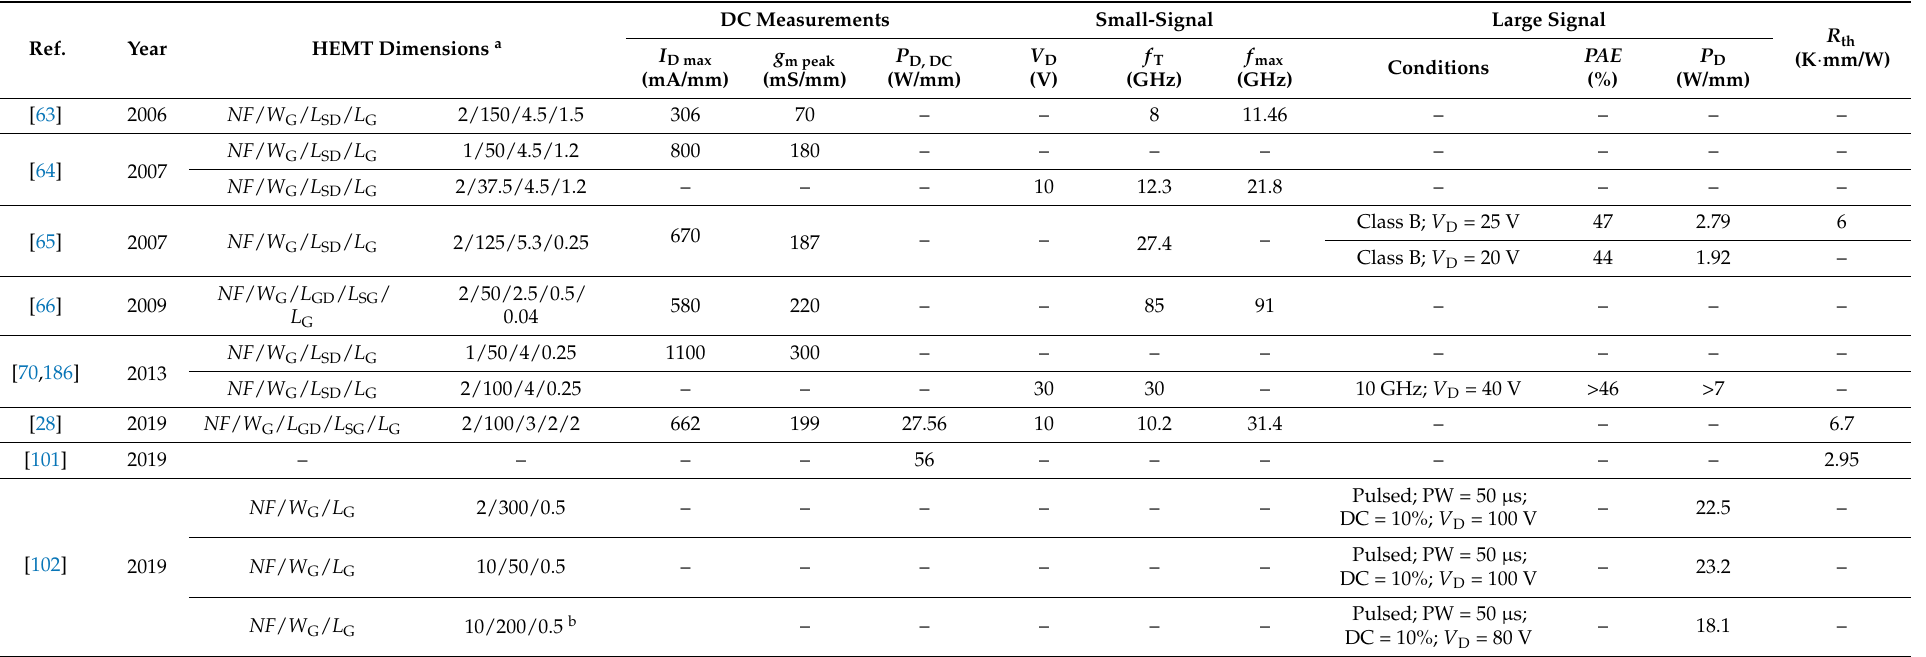
Table A1. Relevant electrical parameters of HEMTs fabricated on GaN-on-diamond wafers.